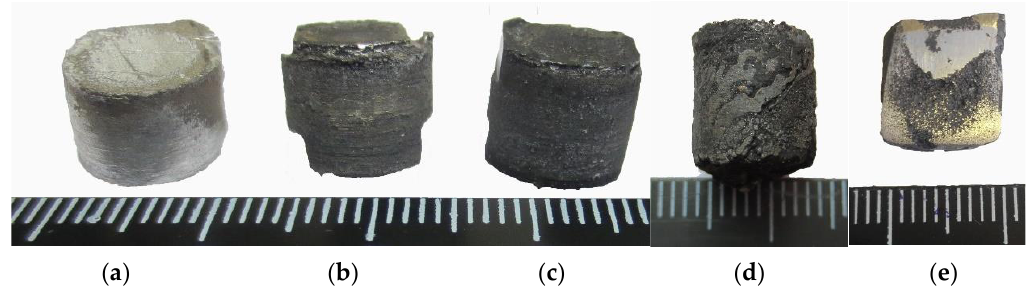
Figure 16. Specimens after shock-wave loading at 1 km/s: ( a ) Ni – Al; ( b ) with 1 wt % PTFE; ( c ) 5 wt % PTFE; ( d ) 10 wt % PTFE; ( e ) 15 wt % PTFE.